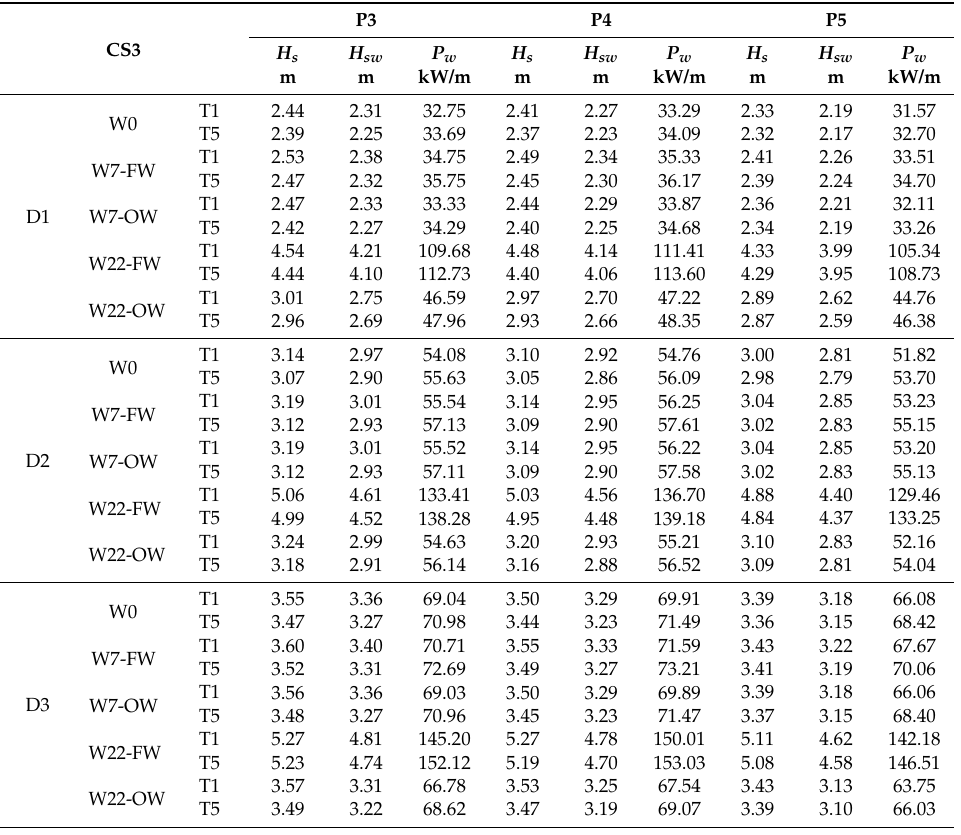
Table 6. SWAN results for CS3, corresponding to the reference points P3, P4, and P5, the tide levels T1 and T5, and the wind conditions W0, W7, and W22, in terms of the wave parameters H s , H sw , and P w